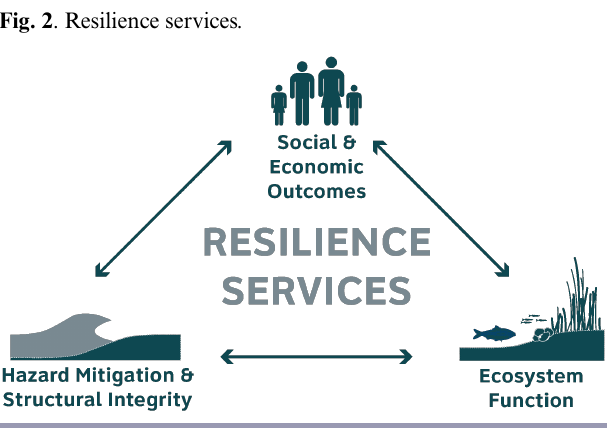
Fig. 2 . Resilience